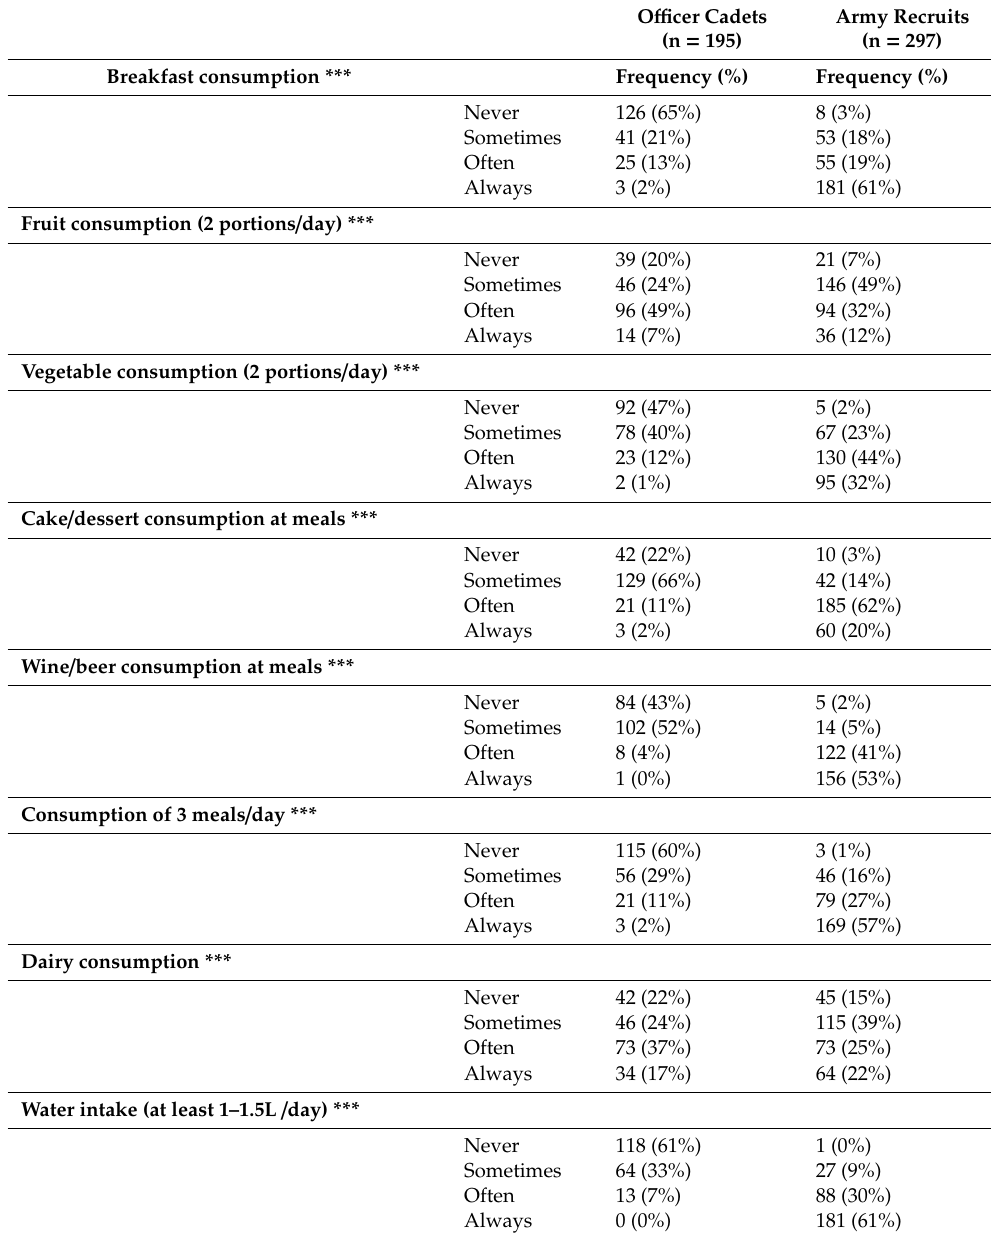
Table 2. Healthfulness of eating behaviours of ADF